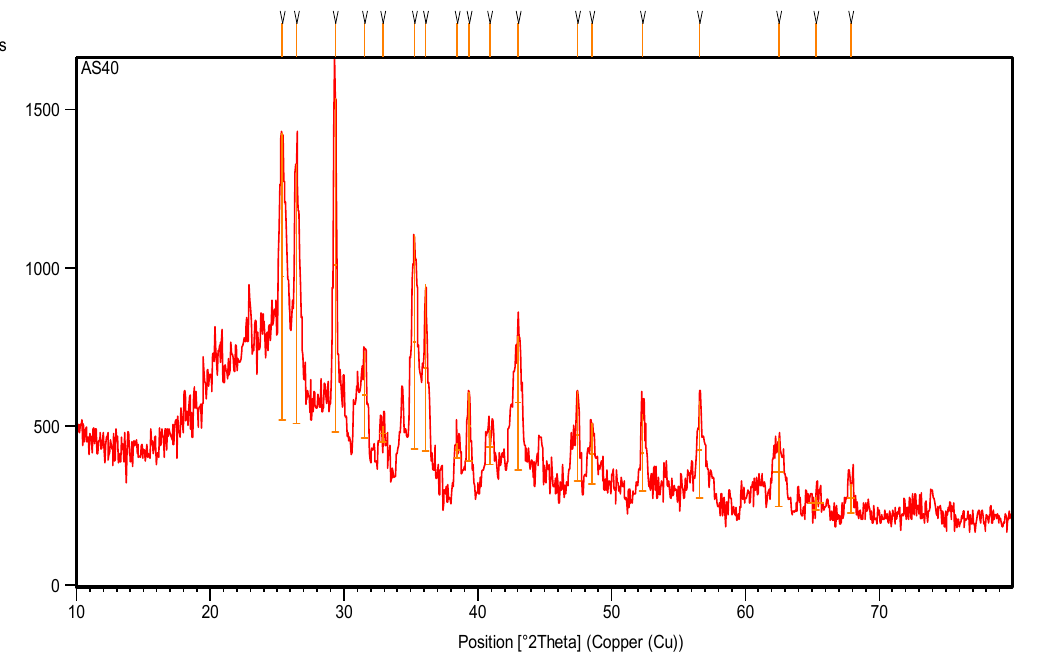
Figure 10. XRD pattern of pyrolytic carbon black recovered from scrap tire. Table 5. XRD intensity scan data of pyrolytic carbon black recovered from tire waste. Peak Position at 2 θ